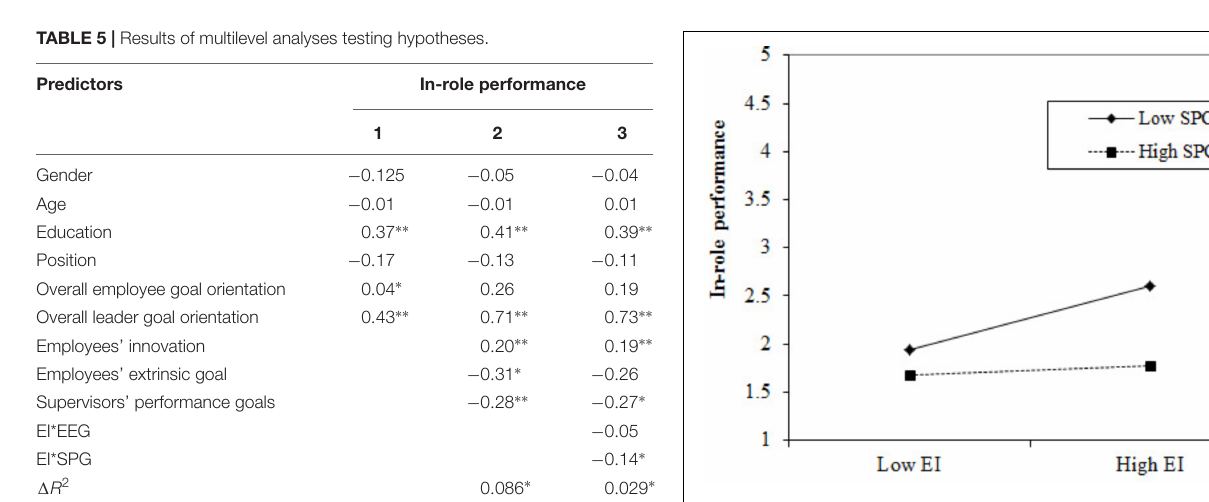
FIGURE 1 | Three-way interaction effects of El by SPG and EEG on employee relationship conflicts.